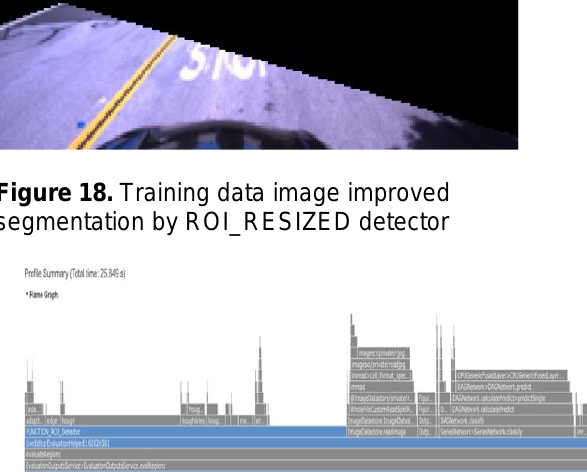
Figure 19. Flame graph for FPS test on 412 images using standard ROI